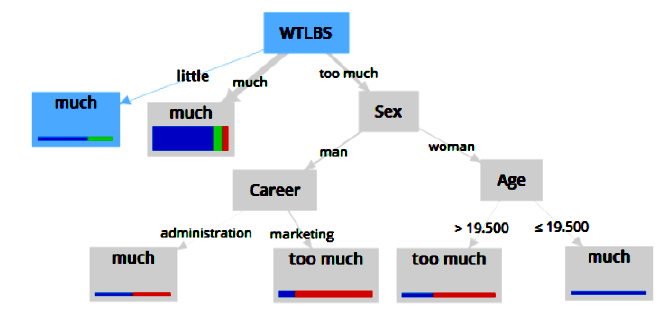
Figure 5. The predictive model 3 on the use of the web application for the teaching-learning process on bank savings (source: created by authors)